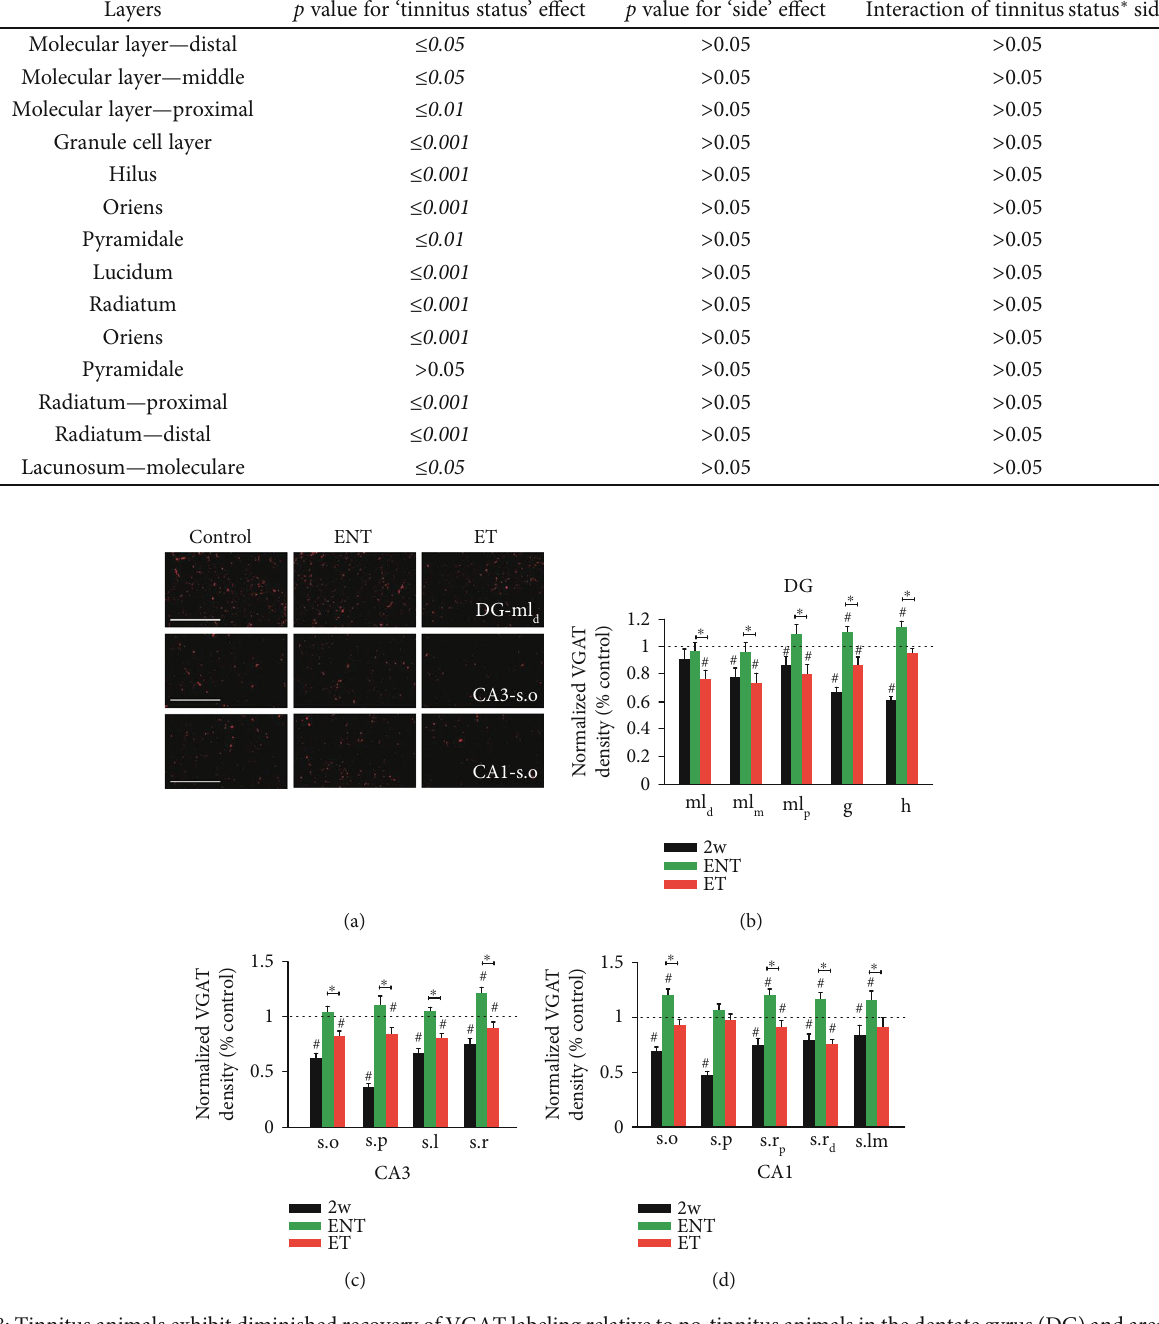
Figure 8: Tinnitus animals exhibit diminished recovery of VGAT labeling relative to no-tinnitus animals in the dentate gyrus (DG) and areas CA3 and CA1. (a) Representative images of VGAT labeling from distal molecular layer of the DG (DG-ml ), stratum oriens of CA3 (CA3- d s.o), and stratum oriens of CA1 (CA1-s.o) at 400x magni fi cation; scalebar = 50 μ m . (b – d) Mean ( ± SEM) change of VGAT density (normalized to respective control) in the DG (b), CA3 (c), and CA1 (d) in two-week and 12-week postnoise-exposure animals. Compared to 2-week postexposure animals (2w), 12-week postexposure animals (ENT and ET) largely recovered to or near to baseline levels. Tinnitus animals (ET) exhibit better recovery of VGAT labeling relative to no-tinnitus animals (ENT) in the dentate gyrus(DG) and areas CA3 and CA1. # For comparison to the paired controls (dashed line), p ≤ 0 : 05 . ∗ For comparison between 2w, ENT, and ET groups, p ≤ 0 : 05 . ml : distal region of molecular layer; ml : middle region of molecular layer; ml : proximal region of molecular layer; g: granule cell d m p layer; h: hilus; s.o: stratum oriens; s.p: stratum pyramidale; s.l: stratum lucidum; s.r: stratum radiatum; s.r : proximal region of stratum p radiatum; s.r : distal region of stratum radiatum; s.lm: stratum d